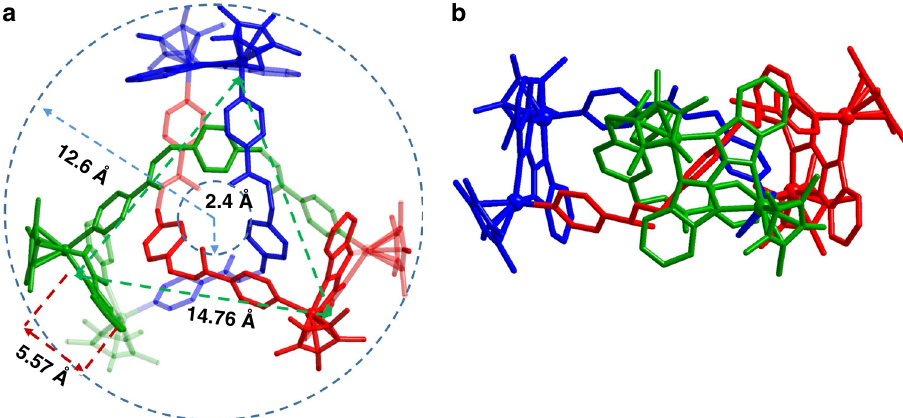
Fig. 5 Single-crystal X-ray structure of 2b . Top view ( a ) and side view ( b ). Counteranions and hydrogen atoms are omitted for